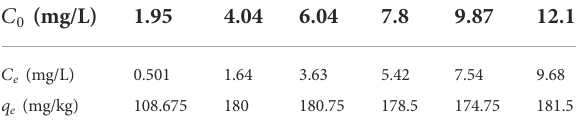
TABLE 1 Results of isothermal adsorption